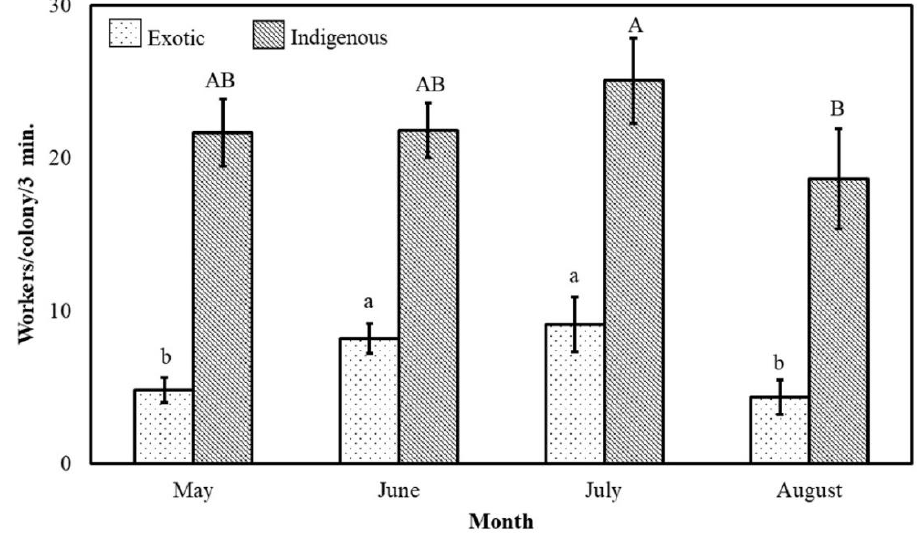
Figure 6. The monthly pollen-gathering rates (mean ± SE) of indigenous ( Apis mellifera jemenitica ) and exotic ( A.m. carnica ) honeybee colonies during the Acacia gerrardii flow (May–August) in Central Arabia for the 2017 and 2018 seasons. The same letter in the same chart line are not significantly ( p > 0.05) different.